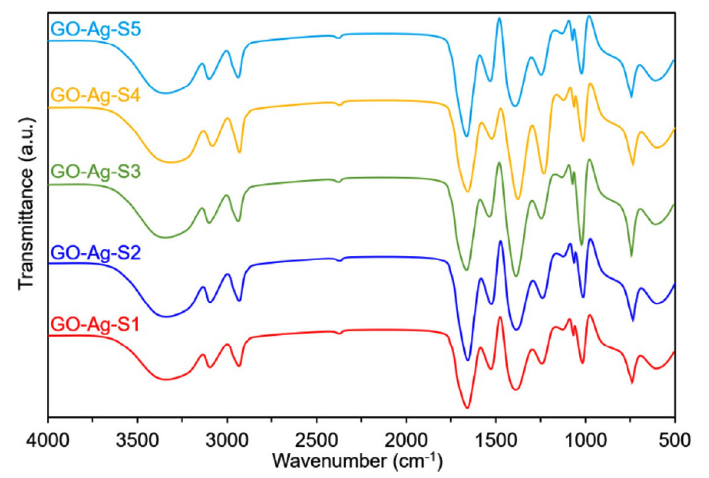
Fig. 6 Typical FTIR profiles of silver nanoparticles loaded graphene-bio-composites.